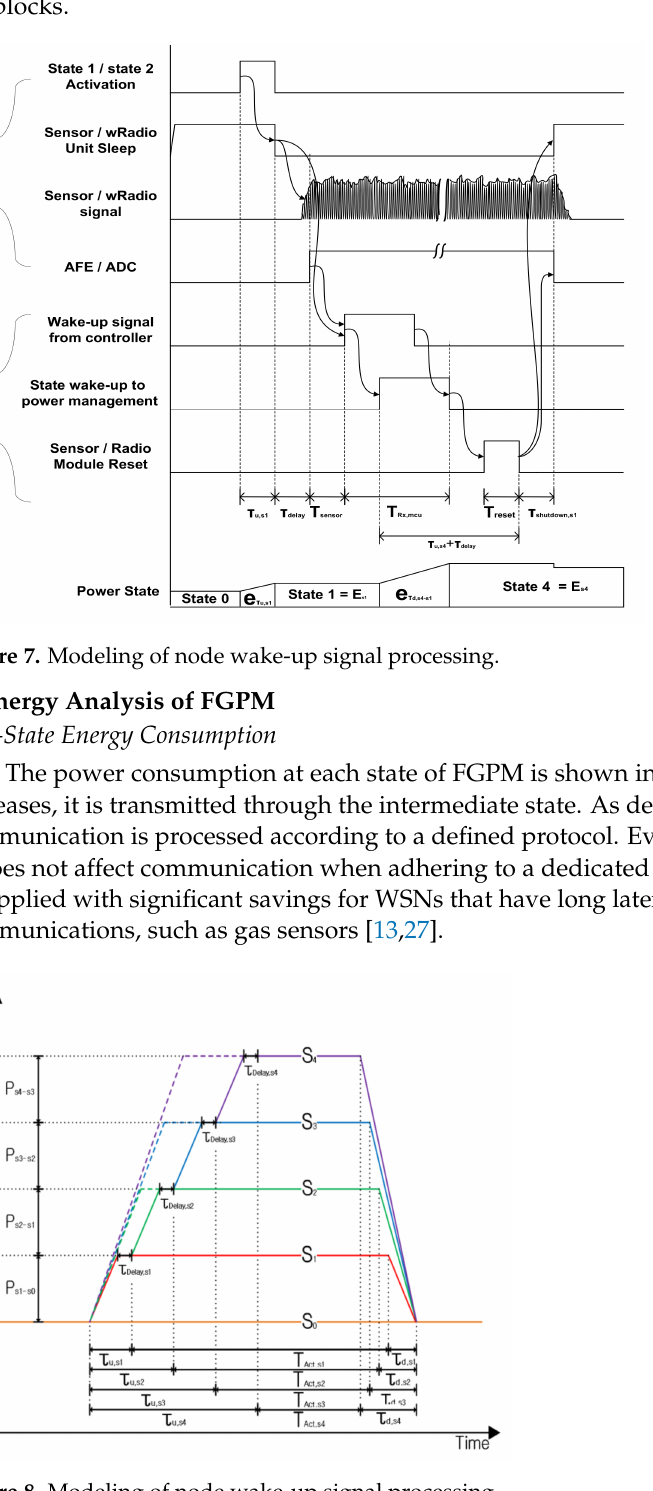
Figure 8. Modeling of node wake-up signal